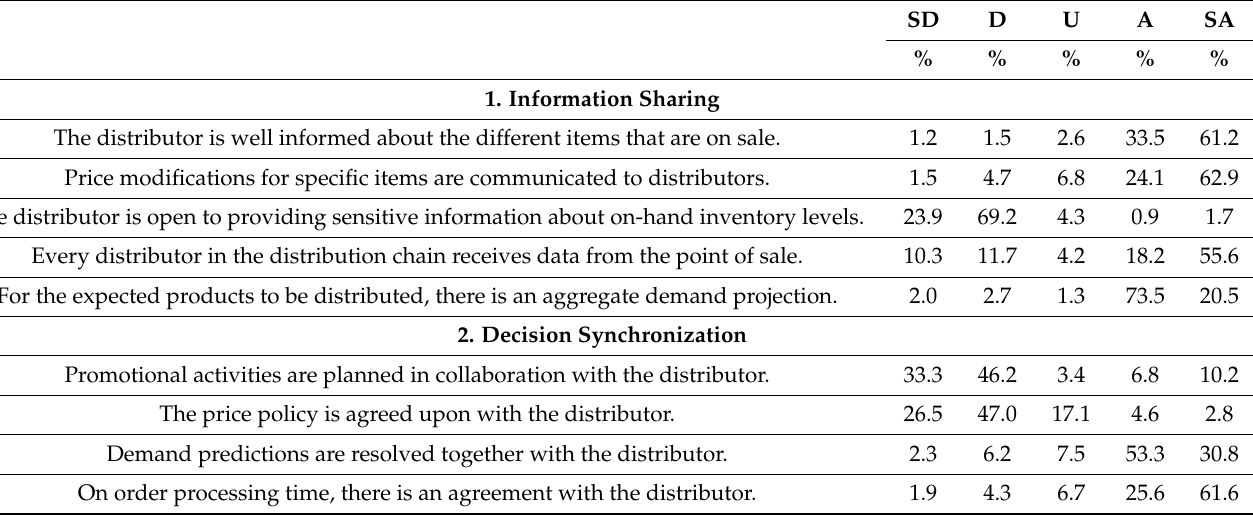
Table 1. Information sharing and decision